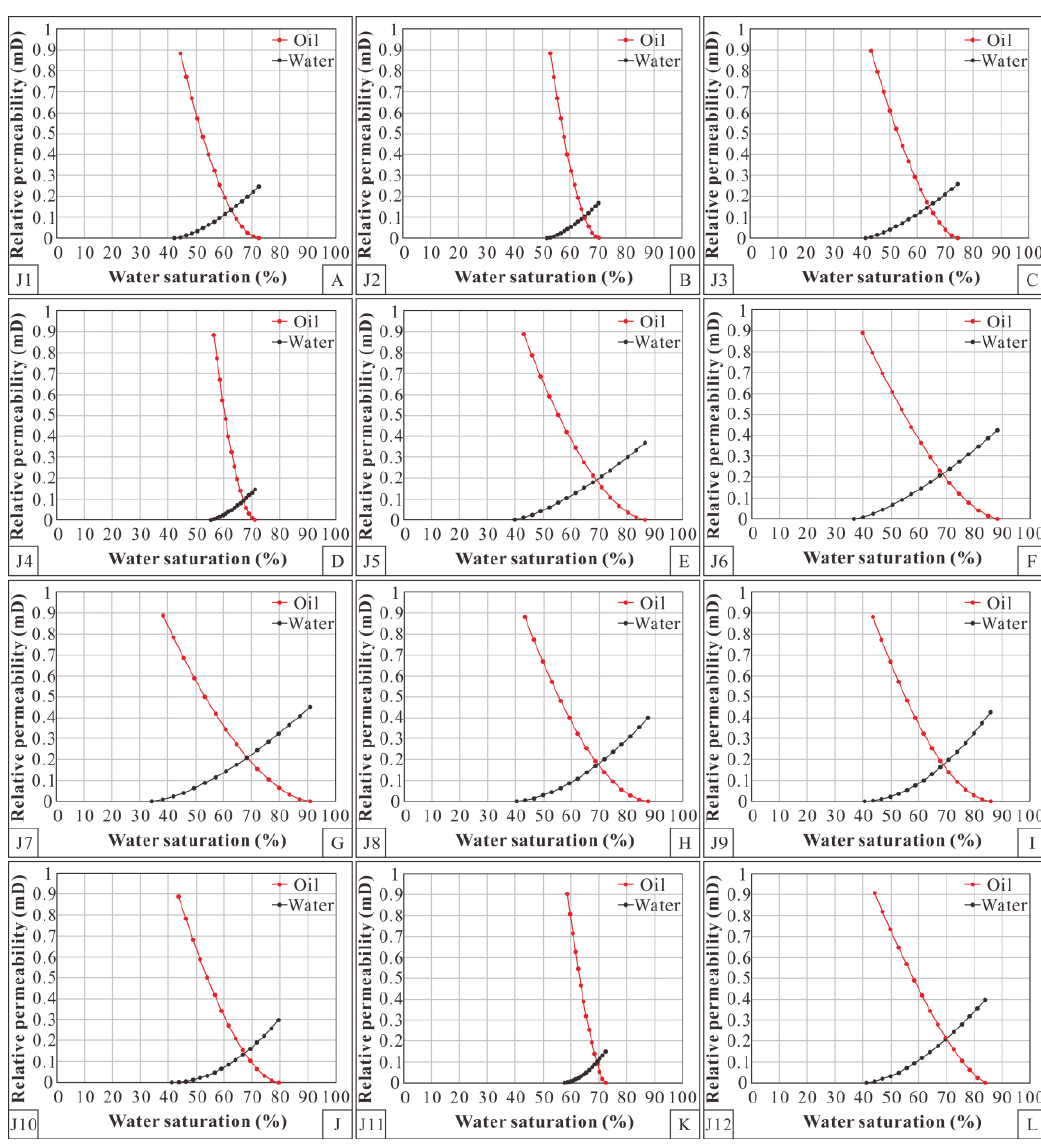
Figure 14. The oil–water relative permeability curves of the 12 typical samples. Figures ( A – L ) correspond to samples J1 to J12, respectively.